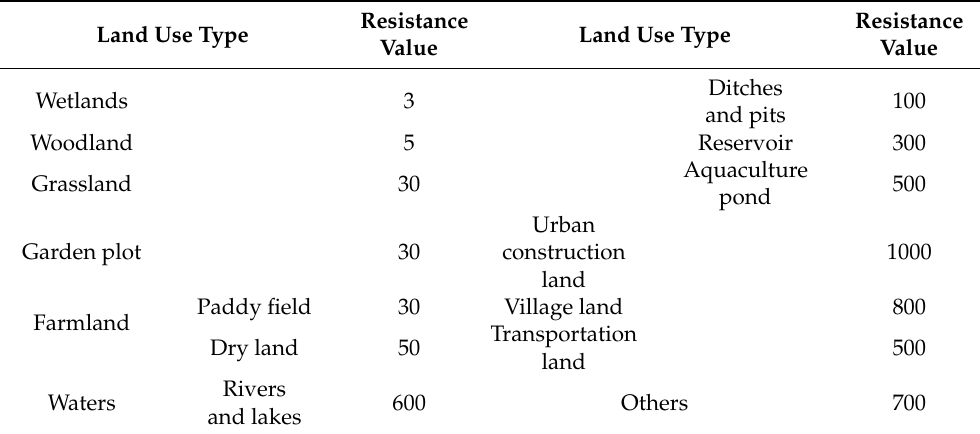
Table 5. Assignment of ecological factors flow resistance based on land use type. Resistance Land Use Type